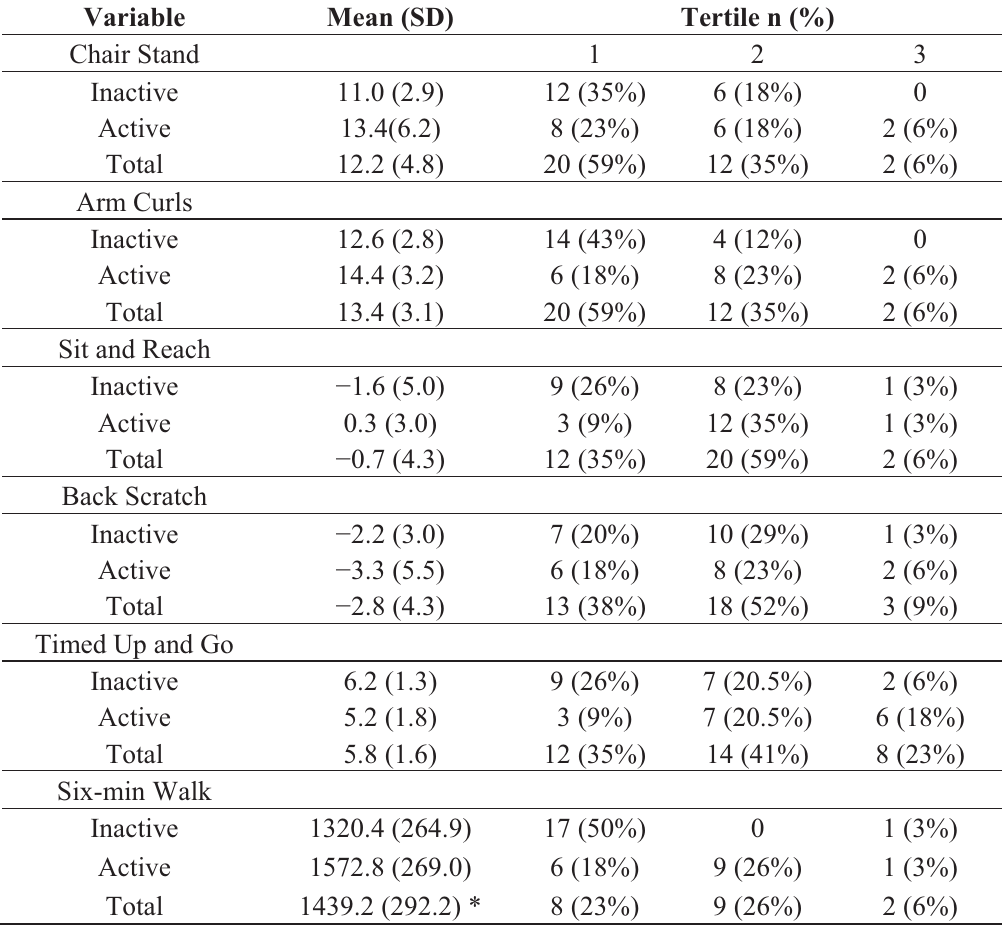
Table 4. Functional Fitness Descriptive ( N = 34, Inactive n = 18, Active n = 16).